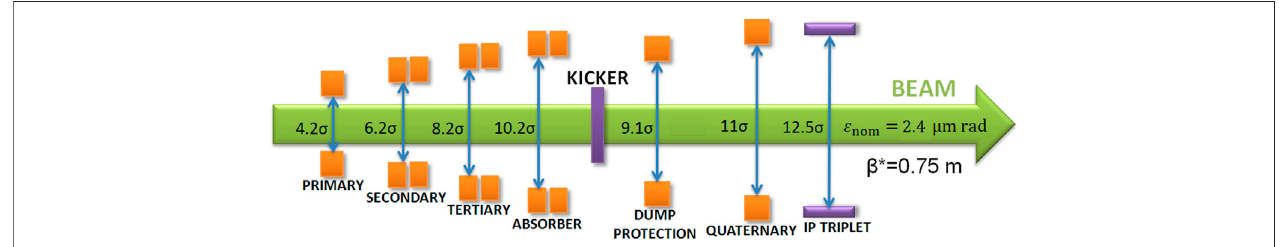
FIGURE5| Schematicforthe fi ve-stagecollimationsystematSPPC.Thekickeranddumpprotection,whichwilloperateinthecasesofmachinemal-functions,are a part of the entire machine protection system.